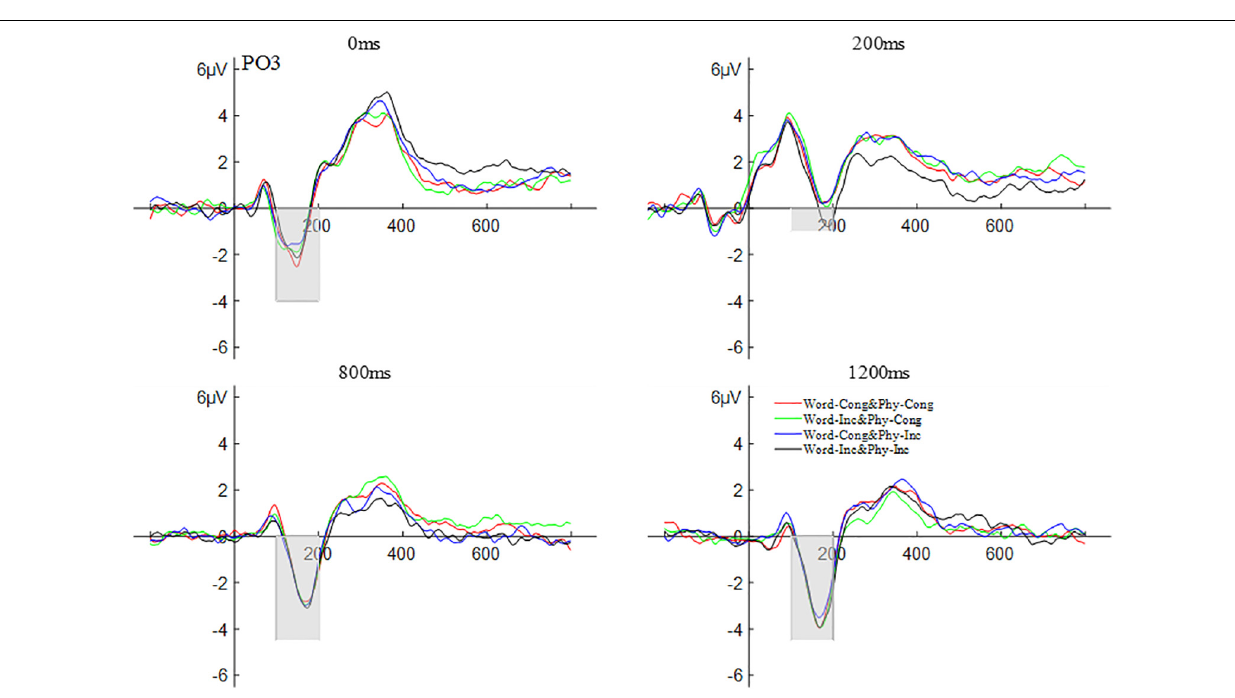
central cognitive and executive functioning, revealed